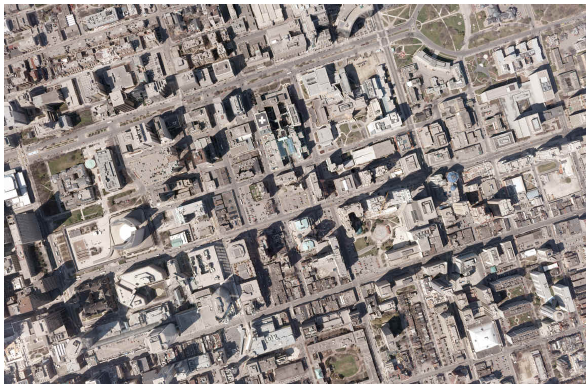
Figure 4. One of the aerial input images of the Toronto dataset.